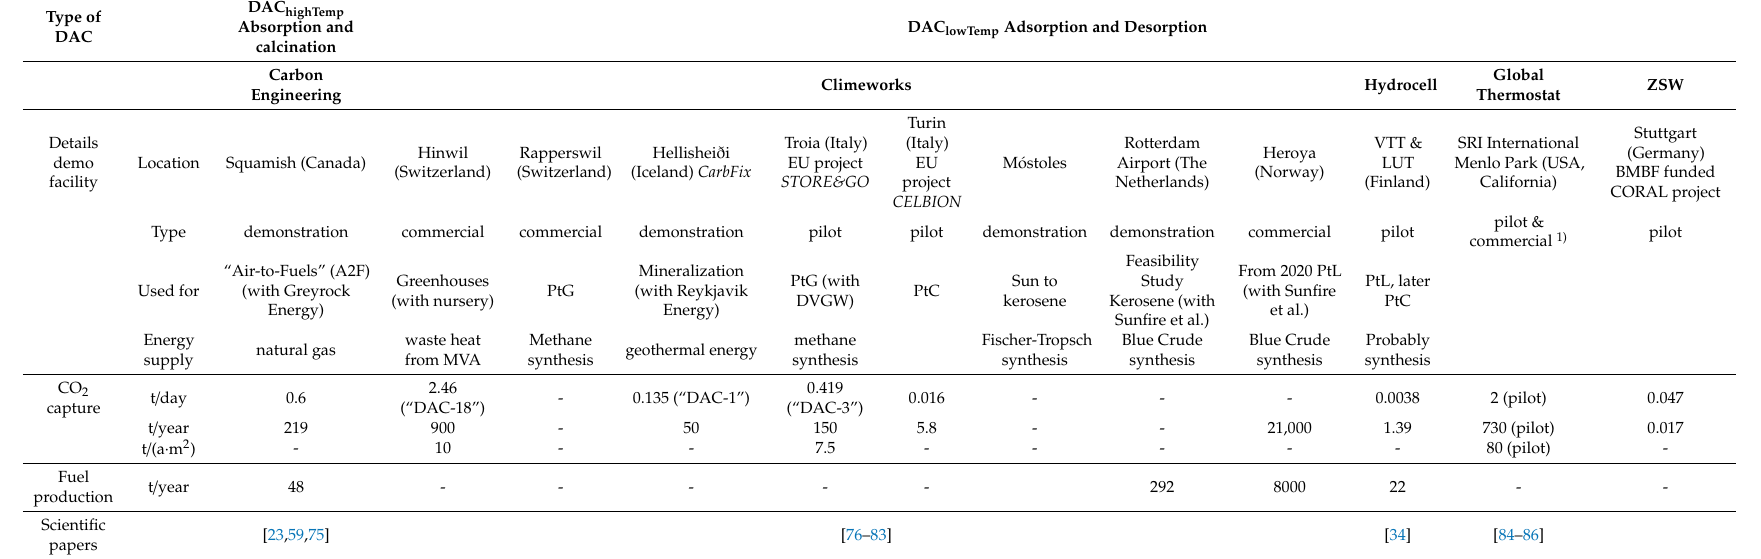
Table A1. Overview and data of published Direct Air Capture (DAC) demonstration facilities, based on